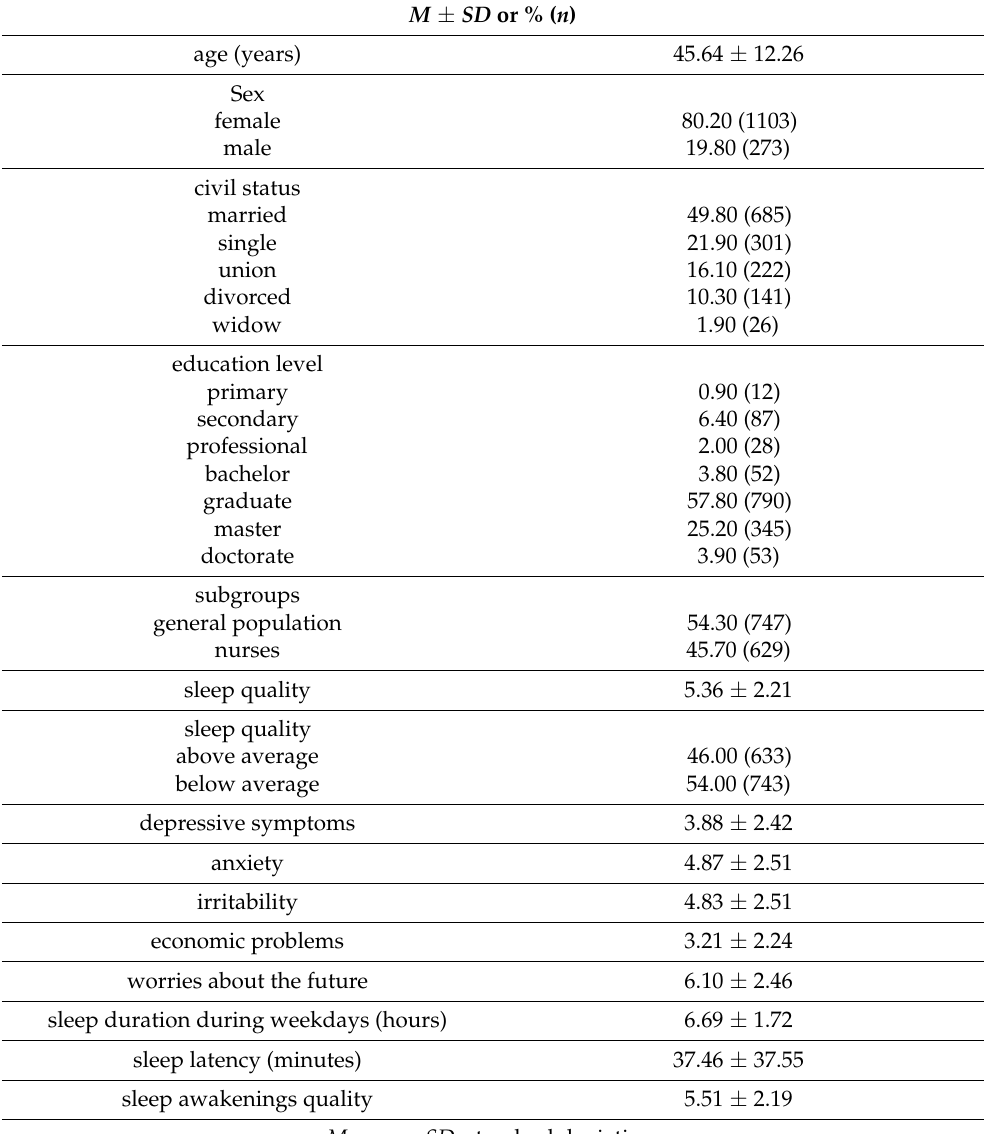
Table 1. Participant characteristics ( n =